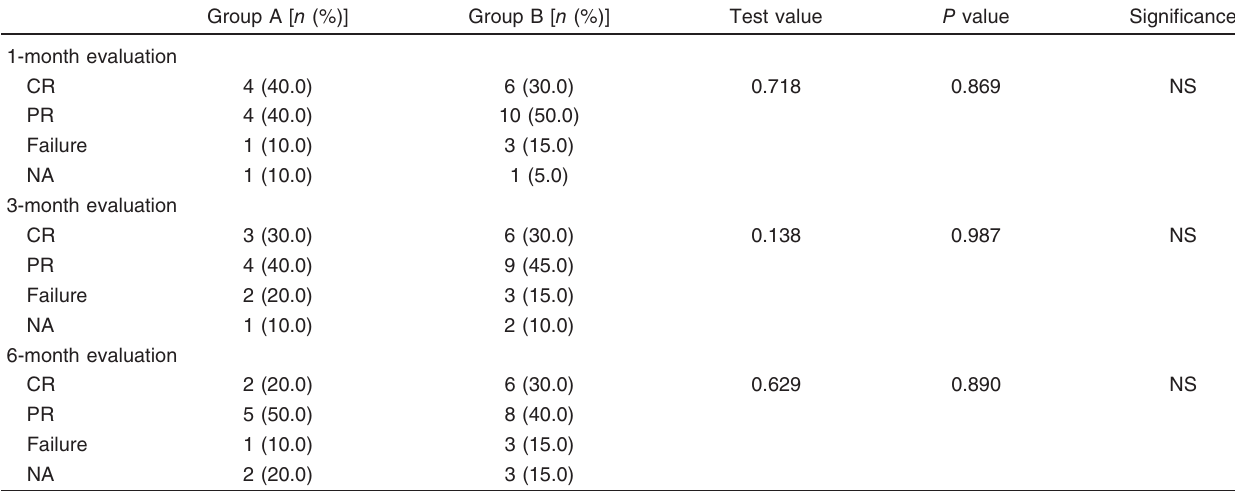
Table 7 The response to pleurodesis in groups A and B after 1, 3, and 6 months ’